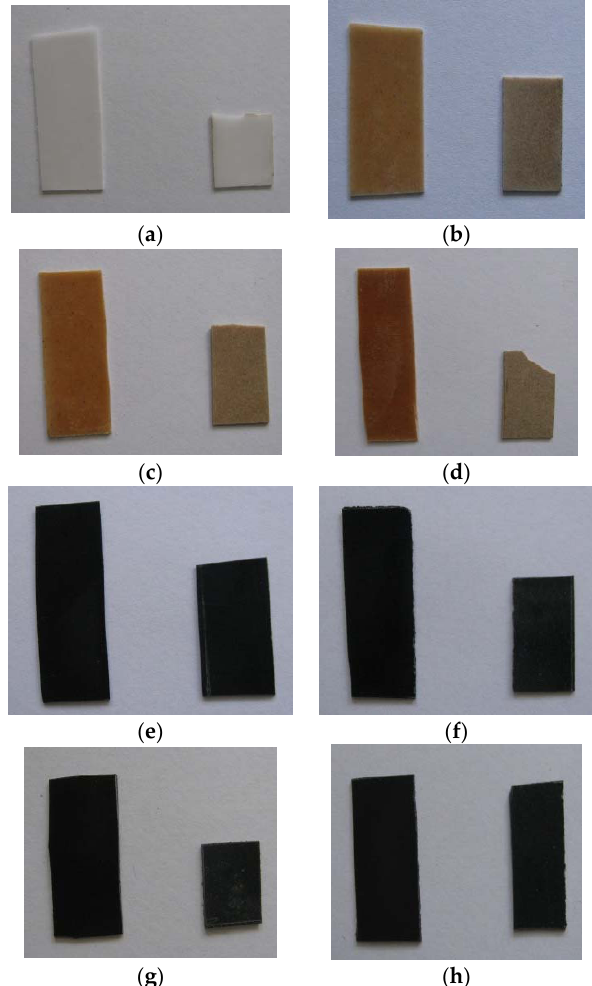
Figure 1. Images of composites before and after burial soil (left—samples before soil burial; right—samples after soil burial). ( a ) virgin (vPP), ( b ) vPP 20cell, ( c ) vPP 30cell, ( d ) vPP 40cell, ( e ) recycled polypropylene (rPP), ( f ) rPP 20cell, ( g ) rPP 30cell, and ( h ) rPP 40cell. The percentage of composites weight loss could be considered an indicator of